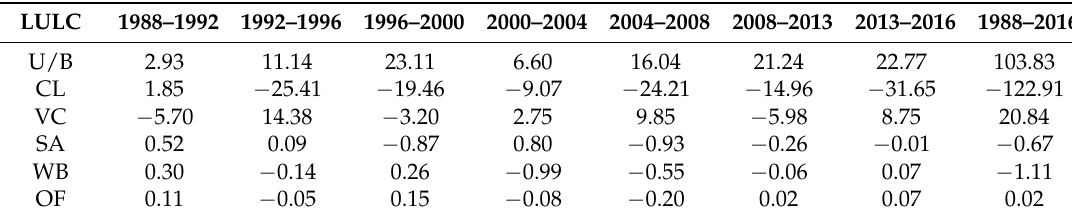
Table 5. LULC magnitude from 1988 to 2016 (in km 2 ).